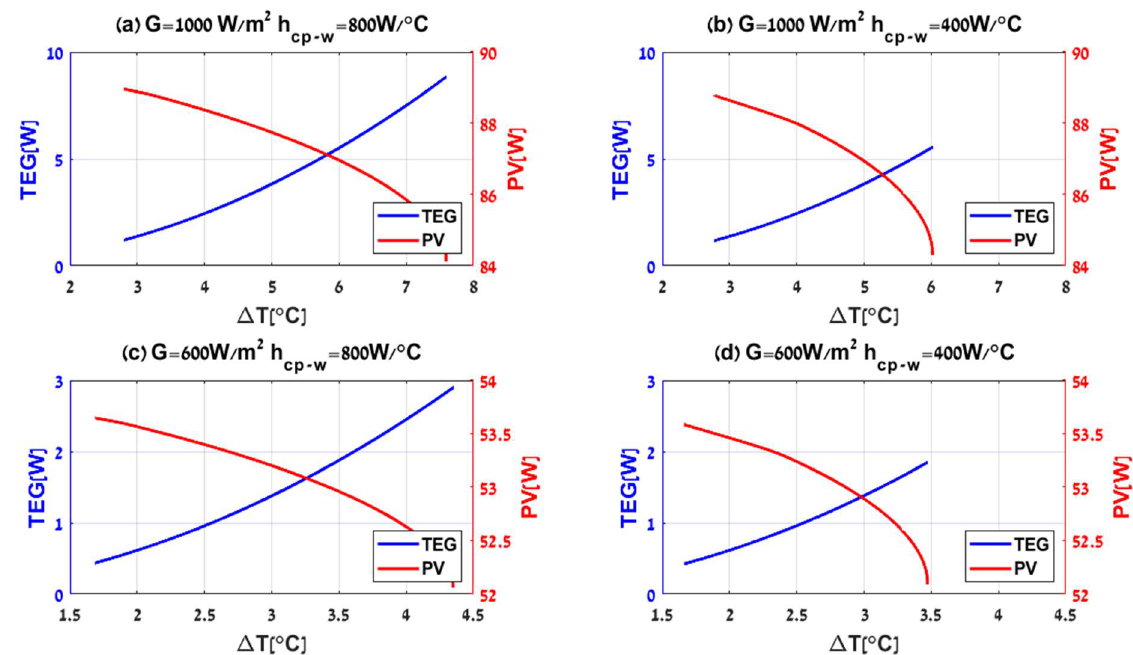
Figure 7. PVTEG dynamics under various irradiances G and water flows 𝑚 (cid:3050)(cid:4593) according to headlines ( a – d ). Table 4. results according to Figure 7.